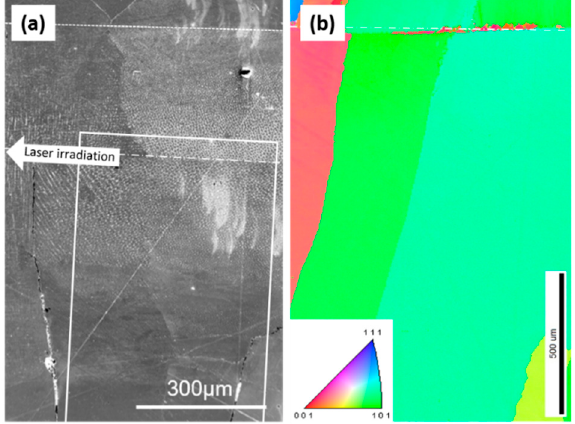
Figure 7. ( a ) Surface FESEM image and ( b ) inverse pole figure (IPF) map obtained by the EBSD analysis of the Ni-9 at.% Al-16 at.% V alloy specimen with a wide laser-irradiated region at a scan speed of 100 mm / s. The IPF map was measured from the laser-irradiated region, as indicated by the solid square in ( a ). The dotted and dashed-and-dotted lines indicate the interface between the substrate and traces of the molten pool, and the cold shut, respectively.